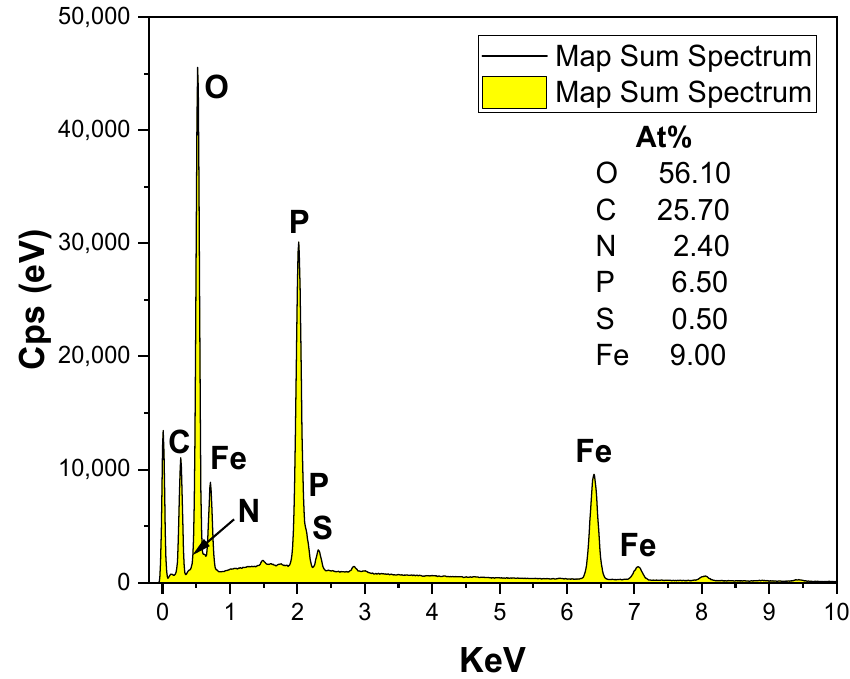
Figure 9. Energy dispersive microscopy (EDS) spectrum for LiFePO 4 –PANI powder.